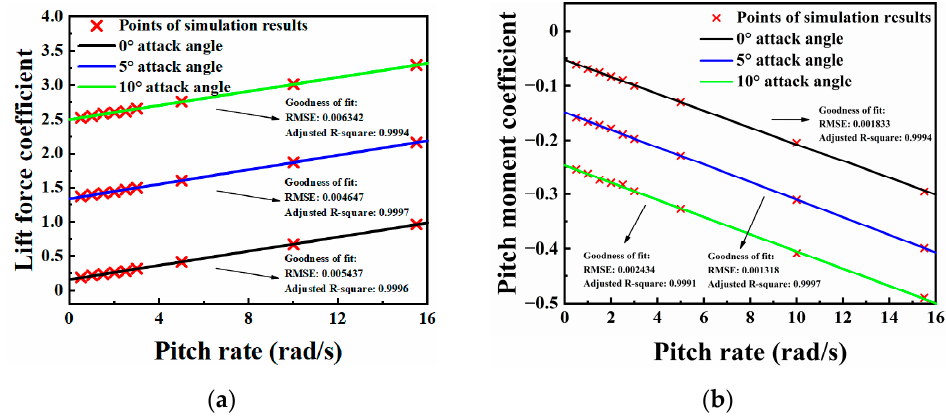
Figure 7. Curve fittings of lift force and pitch moment coefficients versus the pitch rate at various attack angles: ( a ) lift force; ( b ) pitch moment.